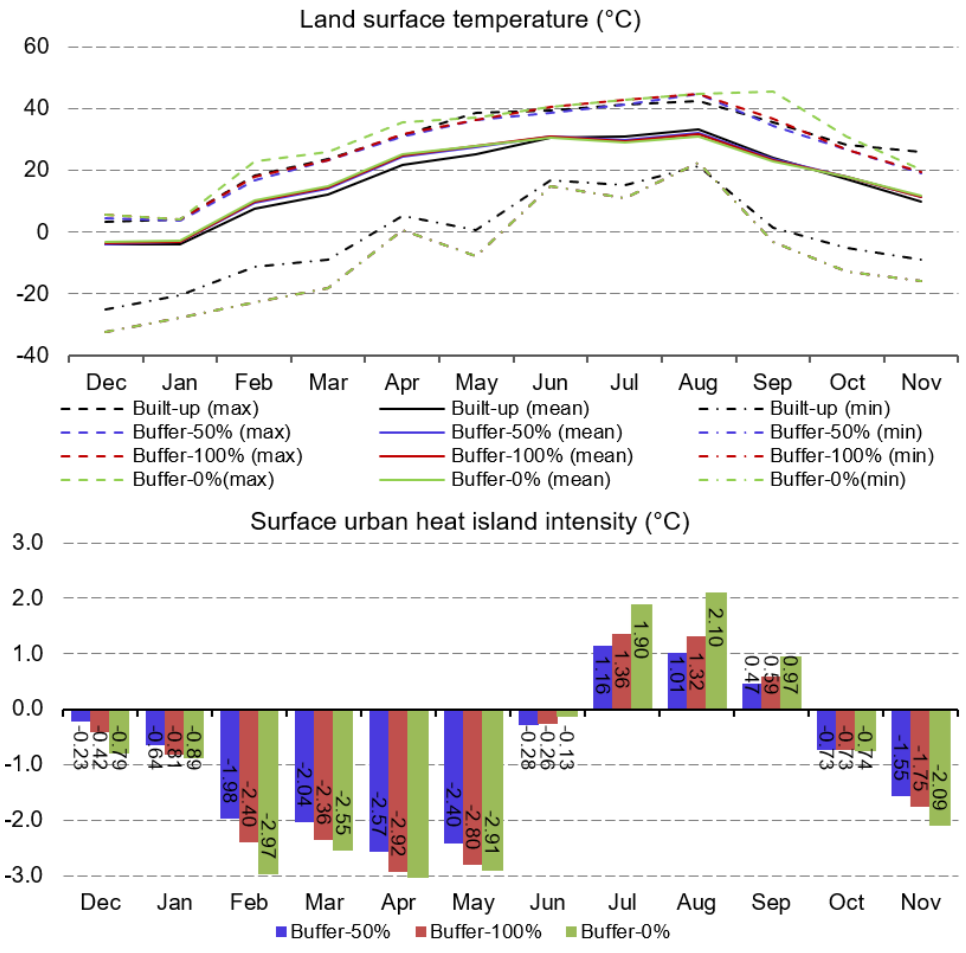
Figure 5. Monthly LST and SUHII variations of the built-up area in buffer 50%, buffer 100% and buffer 0% scenarios from 2018 to 2020.